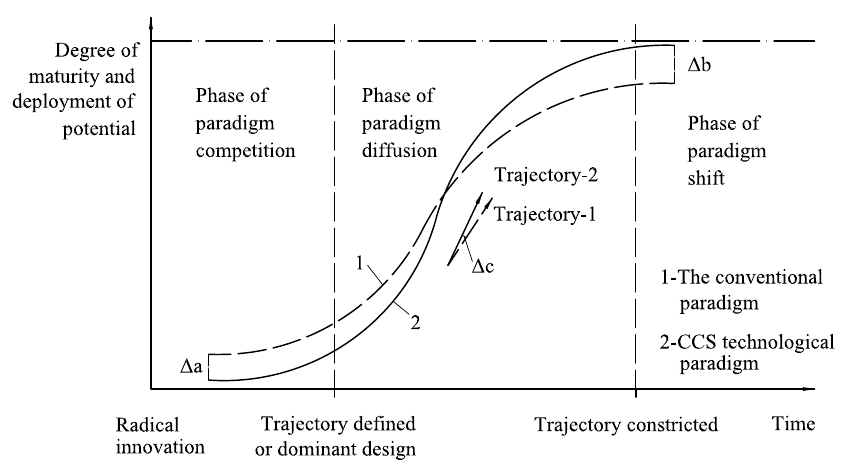
Figure 16. A comparison of the conventional techno-paradigm and CCS techno-paradigm.